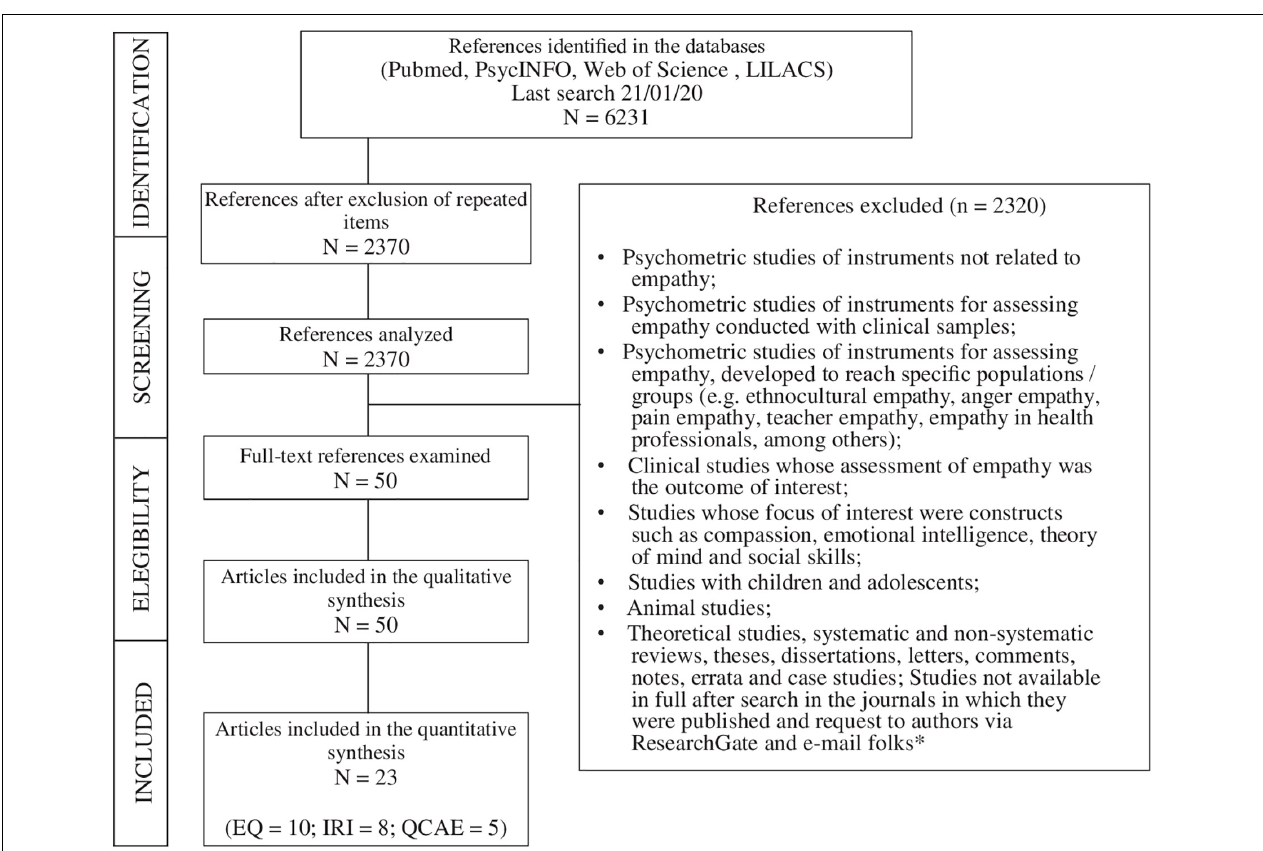
FIGURE 1 | Flowchart describing to the inclusion and exclusion criteria processes based on PRISMA protocol (*Bora and Baysan, 2009; Innamorati et al.,